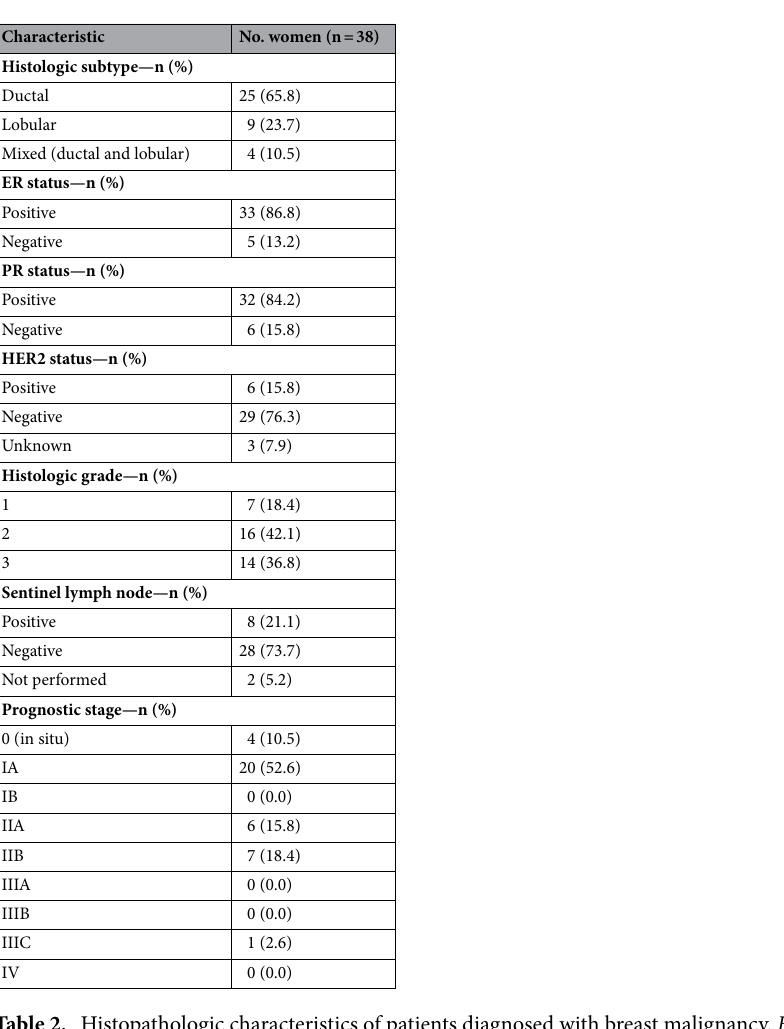
Table 2. Histopathologic characteristics of patients diagnosed with breast malignancy. ER Estrogen receptor, PR Progesterone receptor, HER2 Human epidermal growth factor receptor